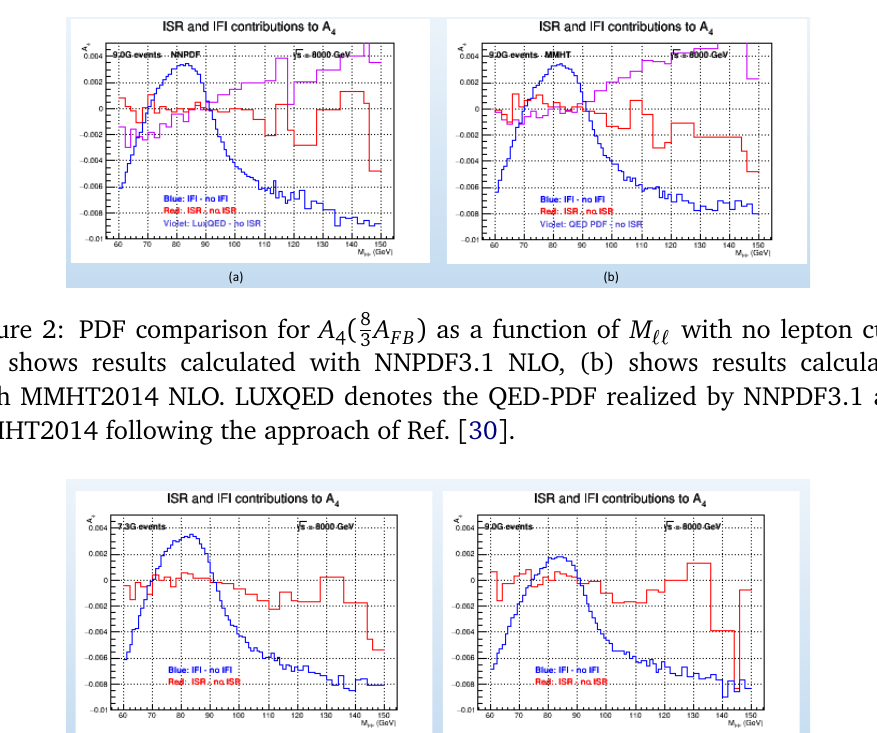
as a function of M (cid:96)(cid:96) with no lepton cuts: (a) shows 4 = 2.2 MeV , m = 4.7 MeV , (b) shows results with these u d